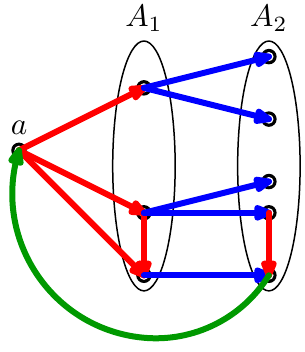
Figure 2: Coloring of the